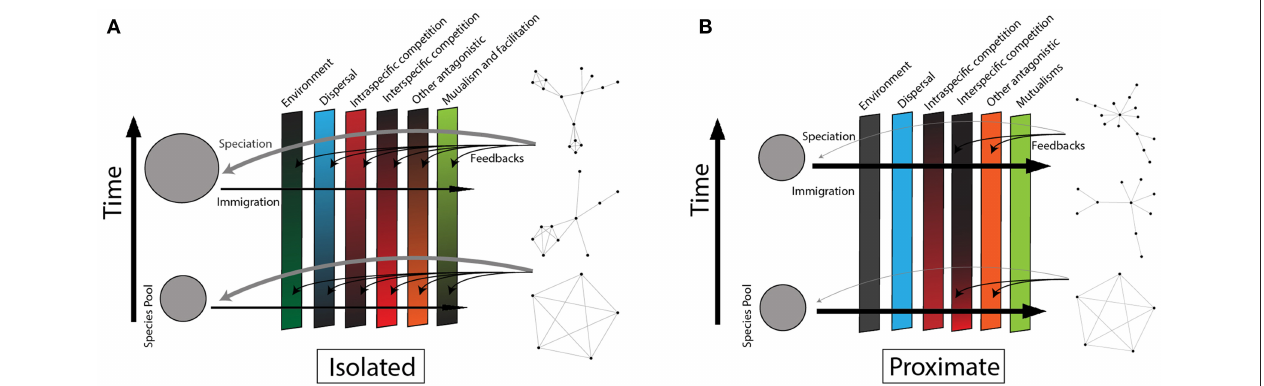
FIGURE 3 | Adaptation of the classic community assembly conceptual model with the addition of species interaction networks. Time and assembly progress from figure bottom to figure top, and species begin in the source pool (left) and progress through the filters to join the community interaction network (right). A variable’s strength in determining which species that can enter a community (“filter”) is indicated by the rectangular panel’s shade (darker color is a strong filter). Interaction structure feedbacks to affect the strength of the variables as filters (black curved arrows). Black horizontal arrows indicate immigration from the source pool and gray curved arrows represent in situ speciation. (A) Represents an isolated community (e.g., Hawaii). The abiotic environment is a weak filter in comparison to dispersal. Few species disperse with their mutualists/facilitators, but these interactions accumulate as species (co)evolve. Once a few species have dispersed, intra-specific competition is high, leading at first to expanding species-level diet breadth as subsets of the population specialize, and then eventually speciate. Inter-specific competition is originally low due to the low rate of immigration and species richness, but this increases as clades diversify and contribute to the species pool. Networks assemble toward niche partitioning and specialization as evolution/coevolution shape species phenotypes to maximize the efficiency of interactions. (B) Represents a non-isolated community (e.g., nearshore mangrove islands). Dispersal is not limited, and species that are pre-adapted to the abiotic environment out-compete others. Inter-specific competition is high, while intra-specific competition is low due to the continual immigration of new species and individuals from neighboring islands. Species and genetic turnover inhibit selection for interaction efficiency, so interactions remain relatively generalized with high overlap. Networks have limited interaction niche partitioning and